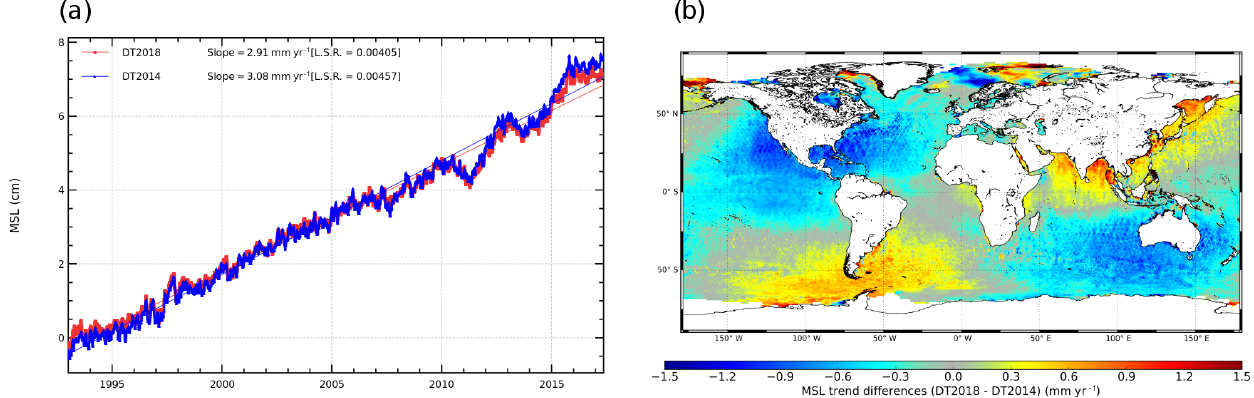
Figure 8. (a) Temporal evolution of the GMSL estimated from DT2018 (red line) and DT2014 (blue line) gridded SLA products. The annual and semi-annual signals were adjusted and no GIA correction was applied. (b) Map of the differences of the local MSL trend estimated from the DT2018 and DT2014 gridded SLA products. MSL was estimated over the 1993–2017